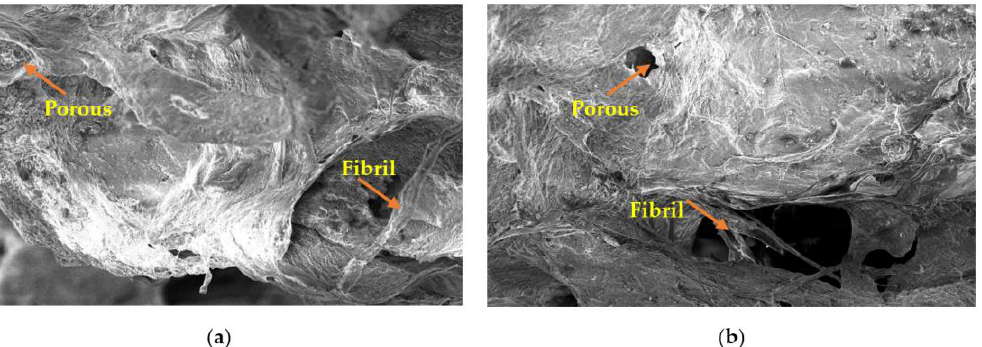
Figure 3. Scanning electron microscopic (SEM) images of PSC at 24 h ( a ) and 48 h ( b ) shows fibril and porous like structure. and porous like